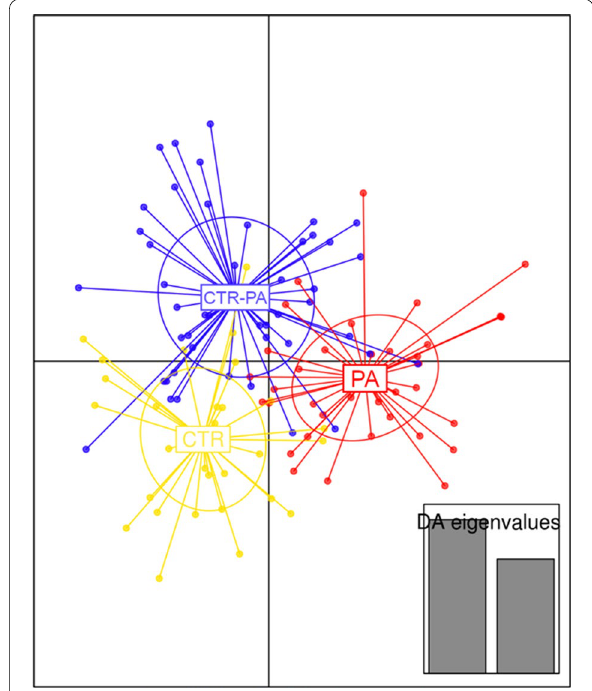
Fig. 3 Discriminant analysis of principal components (DAPC) showing the relationship among 21-day old piglets reared on sows fed different dietary treatments (CTR, CTR-PA and PA). Each dot represents the microbiota profile from one piglet, while each ellipse represents the groups. Discriminant analysis (DA) eigenvalues of the analysis are displayed